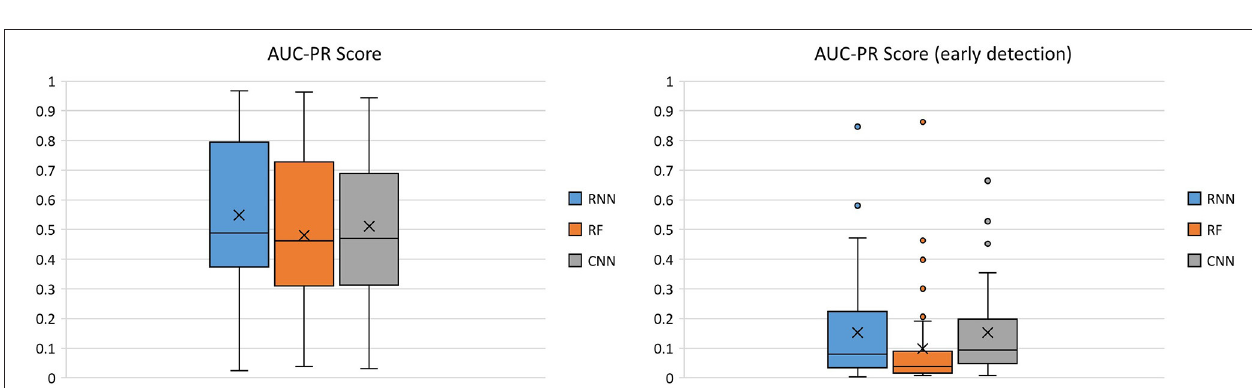
FIGURE 4 | Comparison of the three classifiers across 40 patients using AUC-PR score as the performance metric.